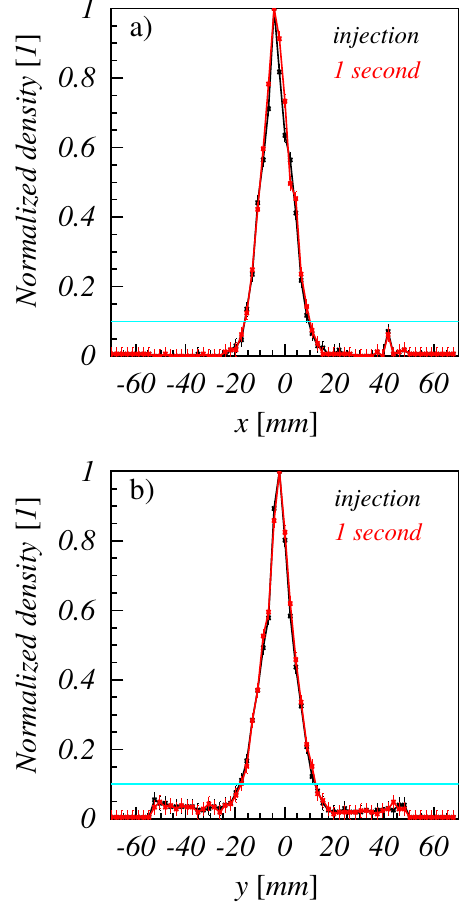
FIG. 2. Layout of the SIS18 and location of the diagnostic devices used.